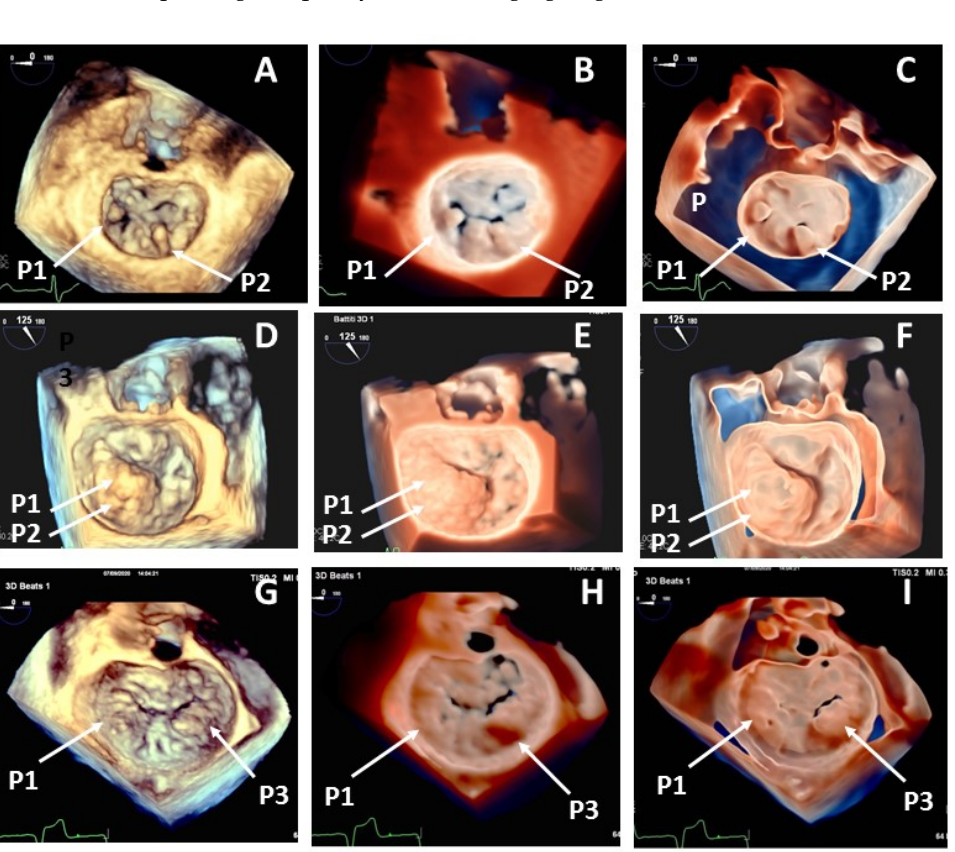
Figure 2. Head-to-head comparison among standard 3DTEE rendering (left panels- A , D , G ), transillumination (central panels- B , E , H ) and transparency (right panels- C , F , I ) in 3 cases with mitral valve prolapse visualized in the surgical view. Case 1 (Upper panels): Segmented-loculated P1 and bilobed P2 prolapses. Case 2 (mid panels): Large P2 prolapse associated with a P1 prolapse. Case 3 (Bottom panels): P1 and P3 Prolapses. Shadowing and transparency improve delineation of scallop borders and malcoaptation areas.